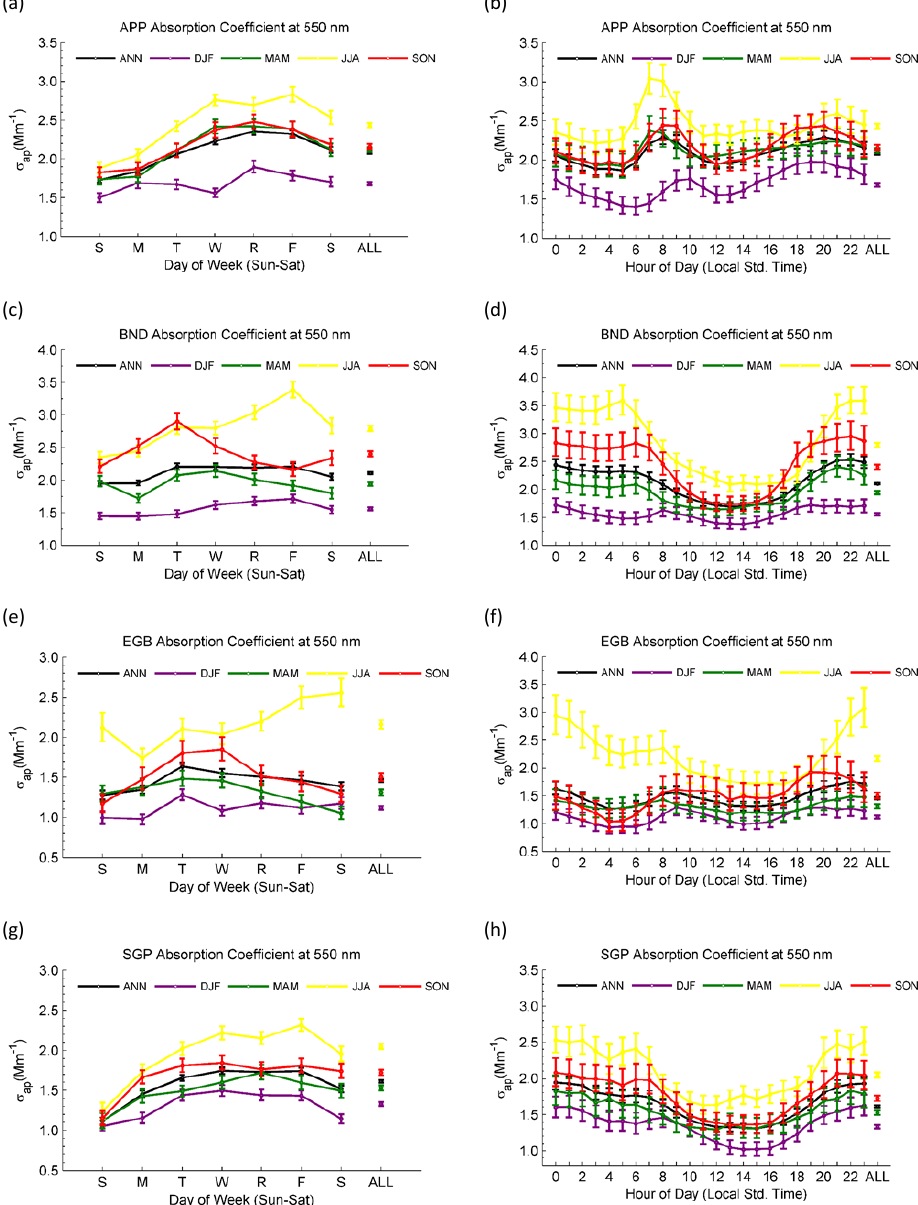
Figure 4. Weekly and diurnal cycles of geometric mean PM 1 σ ap over full years (ANN traces) and for individual seasons at APP, BND, EGB, and SGP over the 2010–2013 period. The value corresponding to the “ALL” data point is the mean value over all days of the week or over all hours of the day. Error bars represent 95% confidence intervals of the mean